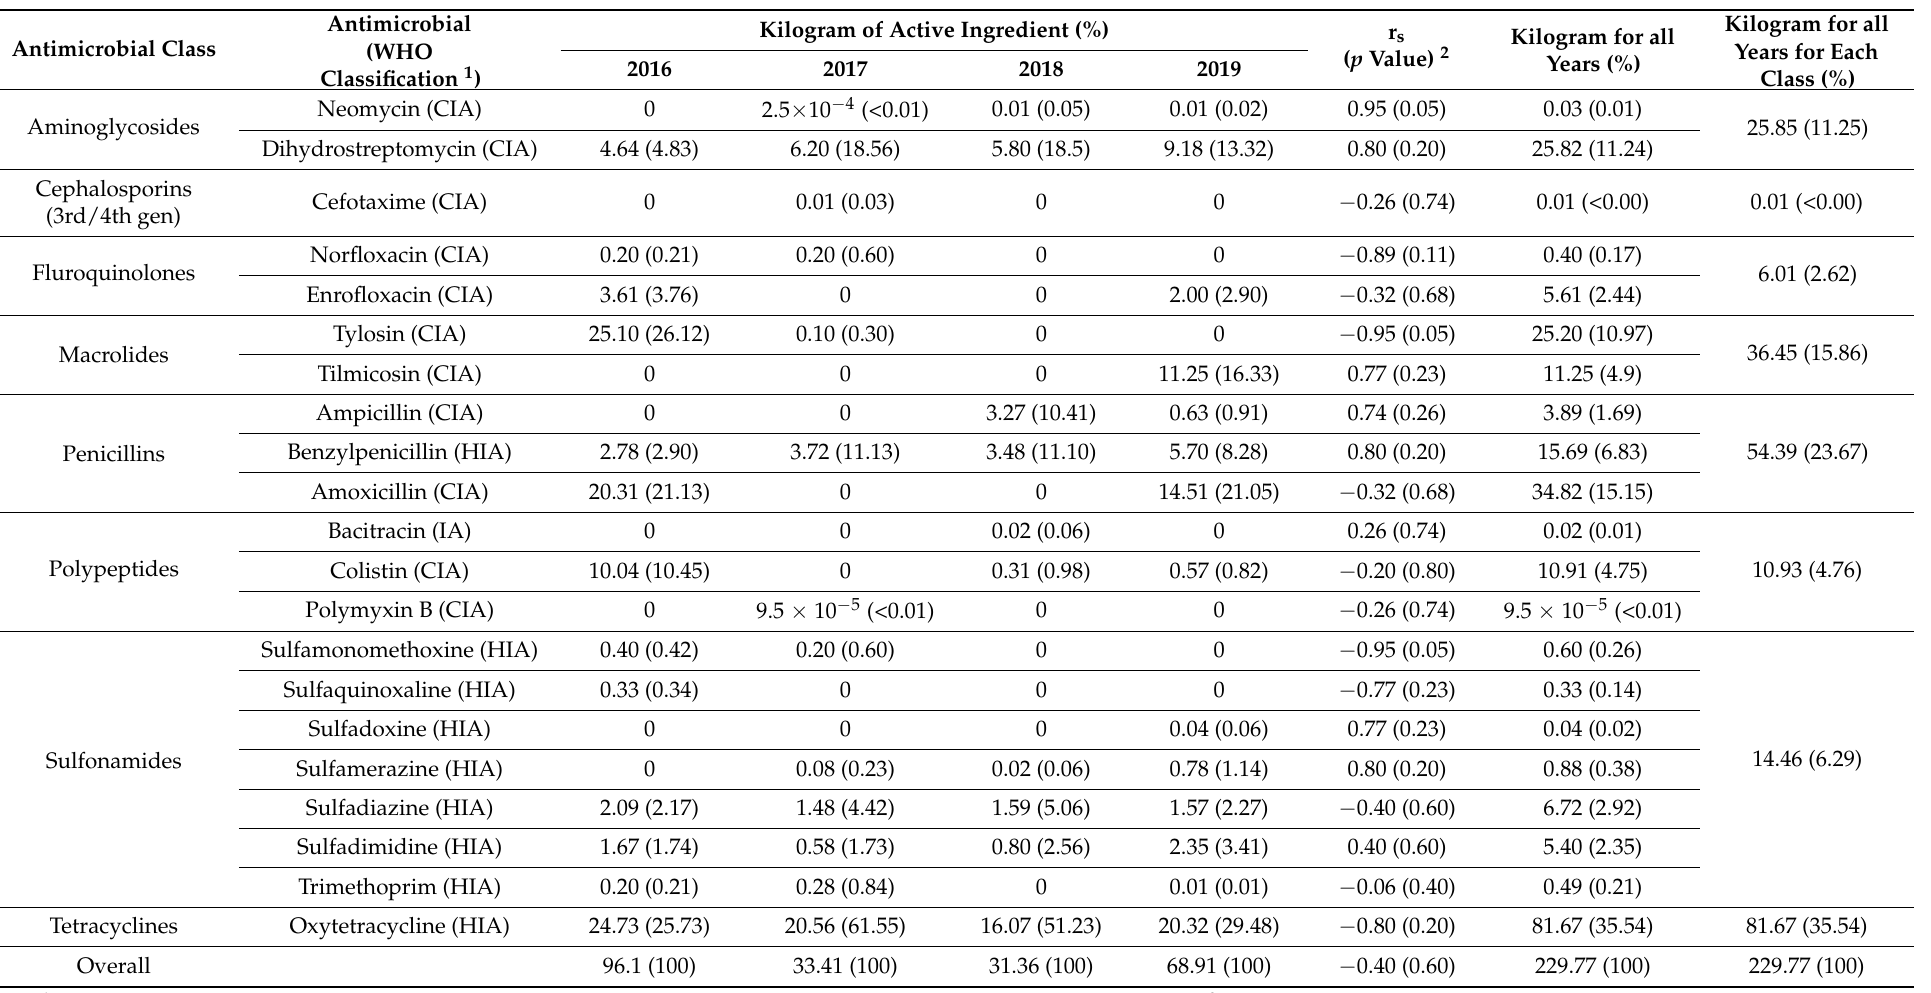
Table 1. Weight of veterinary antimicrobials imported into Timor-Leste between 2016 and 2019, by year and overall for individual antimicrobial and antimicrobial class. Antimicrobial